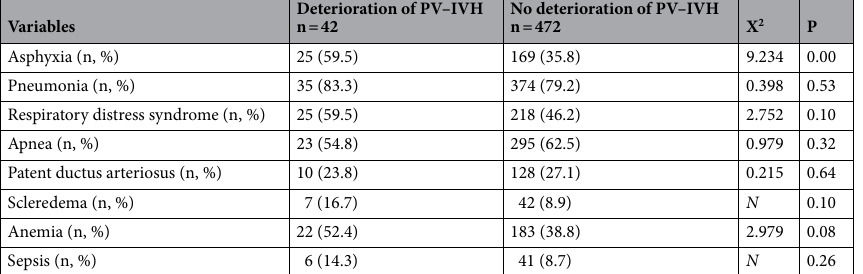
Table 2. Complications of preterm infants with PV–IVH who deteriorated or not. PV–IVH periventricular– intraventricular